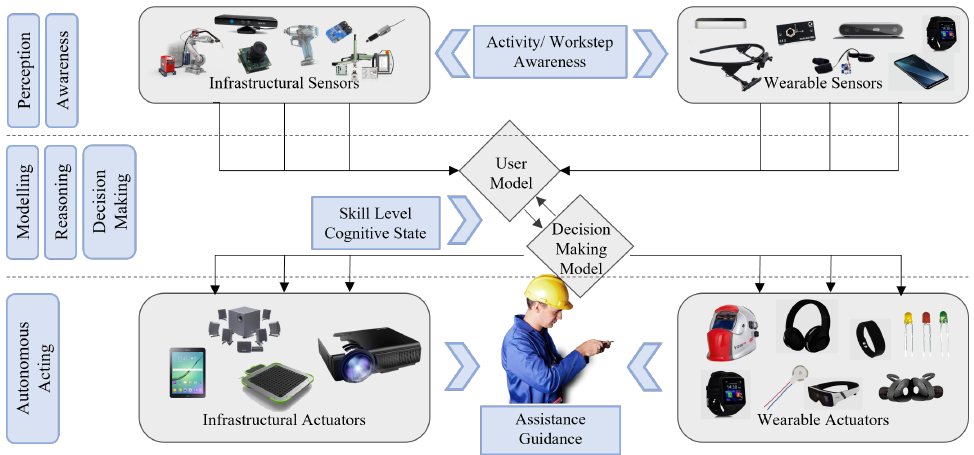
Figure 3. Supporting workers on the shop floor based on a three layered cognitive architecture.